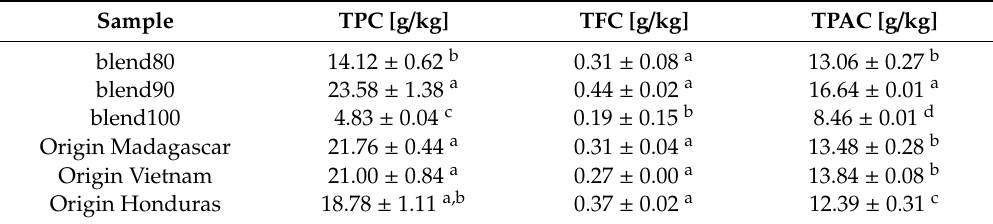
Table 1. The content of total polyphenols, flavonoids, and phenolic